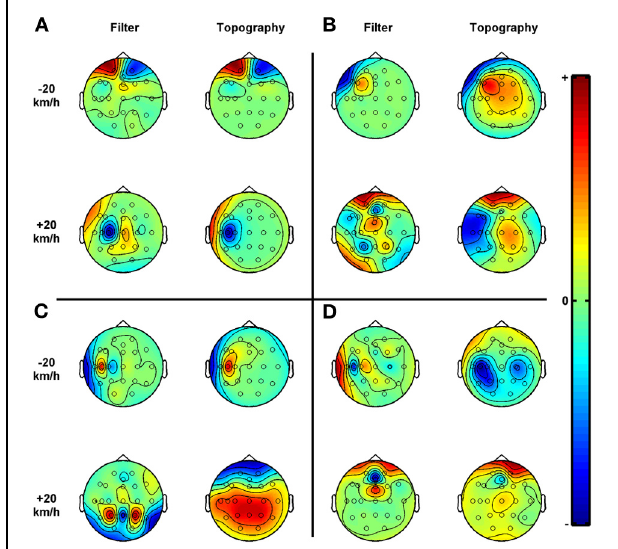
FIGURE 4 | Examples of CSP analyses. (A–D) The scalp topography of the components illustrate how the physiological sources project to the scalp. The components are determined such that projected signals are optimally discriminative. The filters and topographies correspond to the first and last vector of the sorted W matrix and its inverse respectively (see section Design and Procedure for more details). Absolute coloring is arbitrary, however, dense red or blue areas show where the greatest differences in the projected signals’ amplitudes were found, between the − 20km/h and the + 20km/h set driving speed (at normal target level). These driving speeds were set relative to the participants’ preferred speed as determined during the initial ride. Included electrodes: FP1, FP2, Afz, F7, F5, Fz, F4, F8, T7, C5, C3, Cz, C4, T8, P7, P3, Pz, P4, P8, O1, and O2. (A) Subject = 13, frequency band = 72–108Hz, classification accuracy = 100%. (B) Subject = 27, frequency band = 8–12Hz, classification accuracy = 98%. (C) Subject = 21, frequency band = 24–28Hz, classification accuracy = 82%. (D) Subject = 25, frequency band = 8–30Hz, classification accuracy = 74%. Please note that in the CSP literature, a scalp topography of a component is usually referred to as a spatial